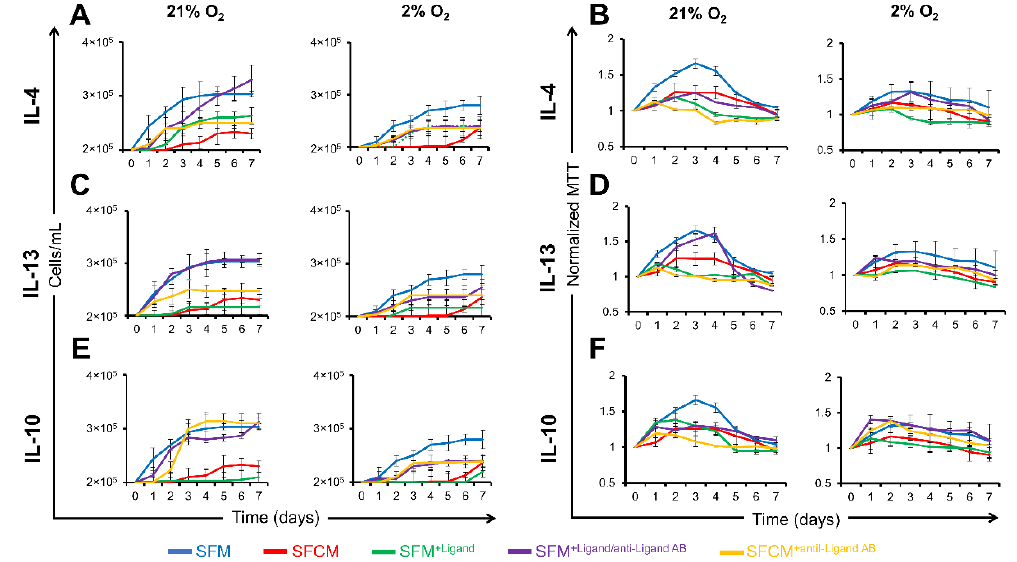
Figure 4. Proliferation of polarised Jurkat T cells is restored in IL-10-devoid SFCM. Growth curve plots calculated from cell counts of polarised Jurkat T cells cultured in SFM, SFCM, SFM +Ligand , SFM +Ligand/antiLigand AB , and SFCM +antiLigand AB in normoxia (21% O 2 ) and hypoxia (2% O 2 ) environments over a 7 day period. ( A ) IL-4, ( C ) IL-13, and ( E ) IL-10. Data expressed as mean ± SD ( n = 3). Optical density (O.D.) values for MTT assays of non-polarised Jurkat T cells cultured in SFM, SFCM, SFM +Ligand , SFM +Ligand/antiLigand AB , and SFCM +antiLigand AB in both air (21% O 2 ) and physoxia (2% O 2 ) environments over a 7 day period. ( B ) IL-4, ( D ) IL-13, and ( F ) IL-10. MTT assay values at each time point were normalised to day 0. Data expressed as mean ± SD, ( n = 3).